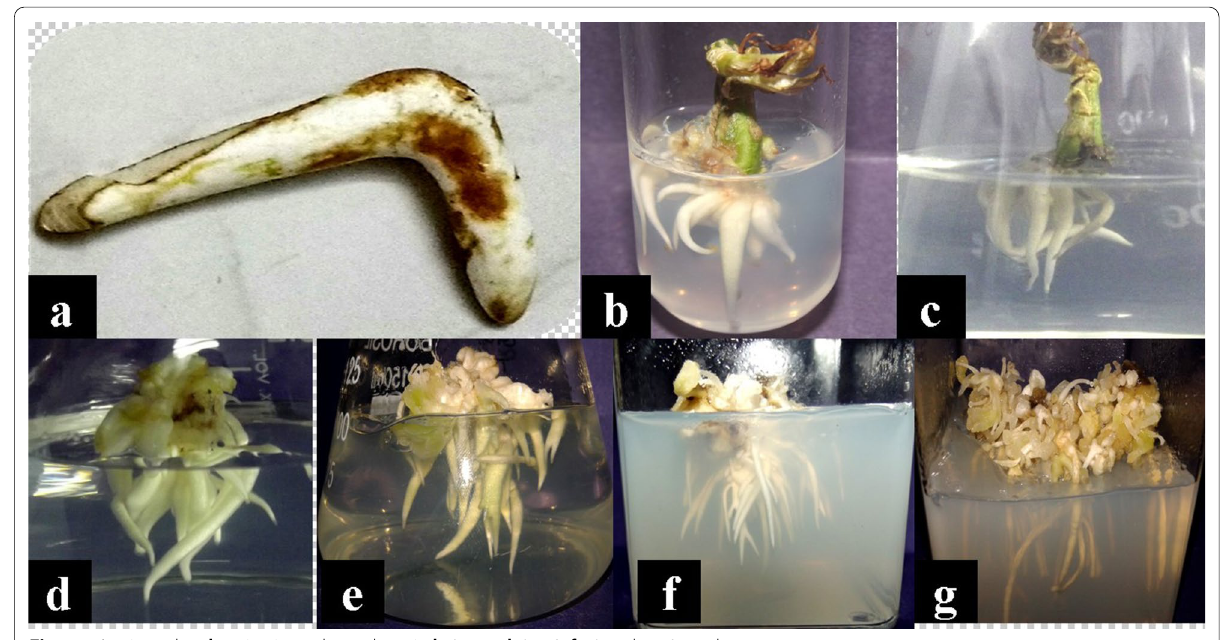
Table 1 In vitro tuber formation in Gloriosa Hormones types Concentration